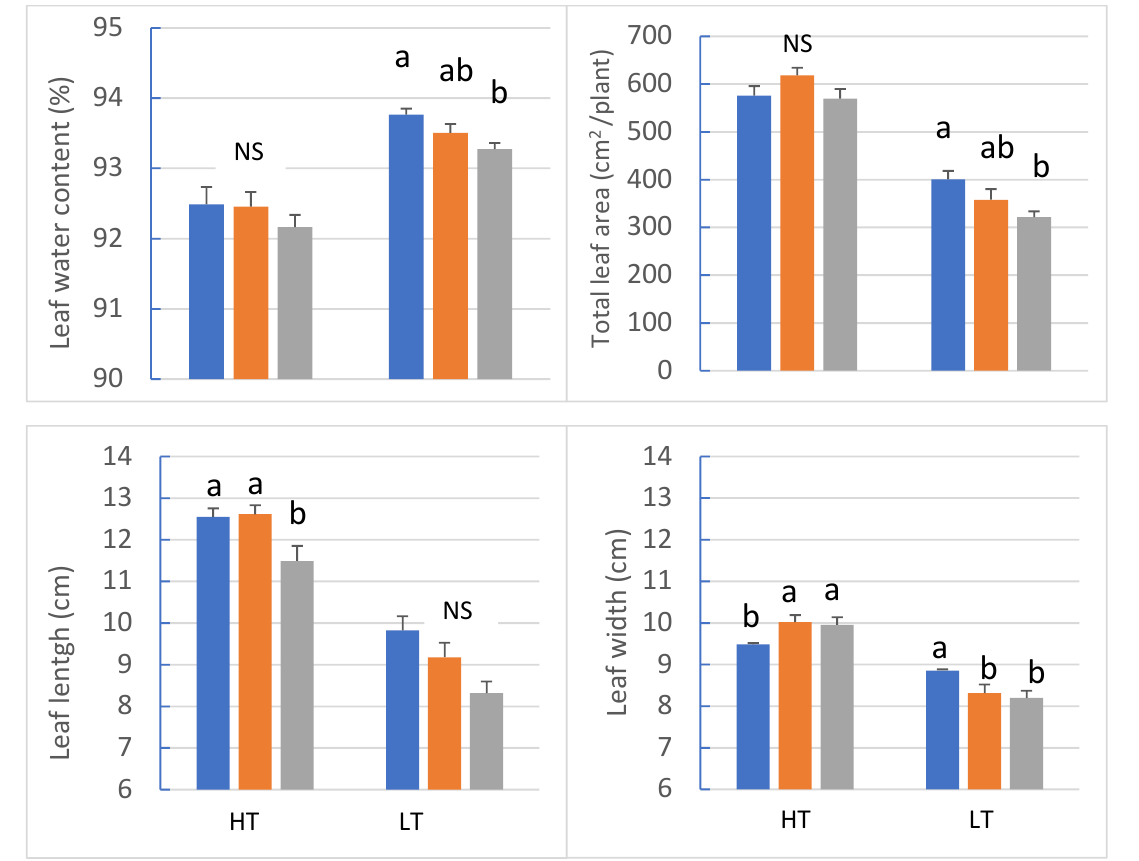
Figure 2. Shoot fresh weight, dry weight, leaf water content, leaf area, and leaf length and width of ‘Cegolaine’ lettuce ( Lactuca sativa ) plants grown under three light spectra (PKF, PKR, PPR) and two temperatures: high temperature (HT, ≈ 30 ◦ C) and low temperature (LT, ≈ 21 ◦ C). Vertical bars represent standard errors. Different letters for the same temperature level indicate significant differences among three light spectra at p ≤ 0.05. NS indicates no significant differences among the light spectra .